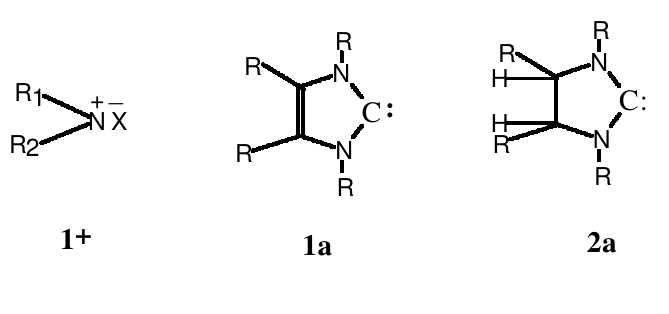
Fig. 1 Stable carbene of the Arduengo (1a) and Wanzlick (2a)